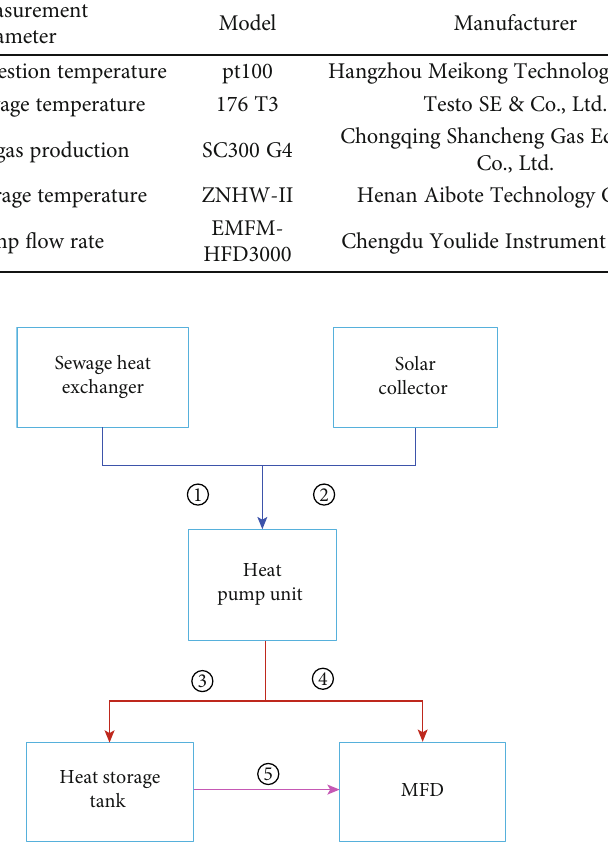
Figure 4: Operating schematic of the SUSSHPS. Table 4: Recommended data for the solar fractions in Sichuan Province.